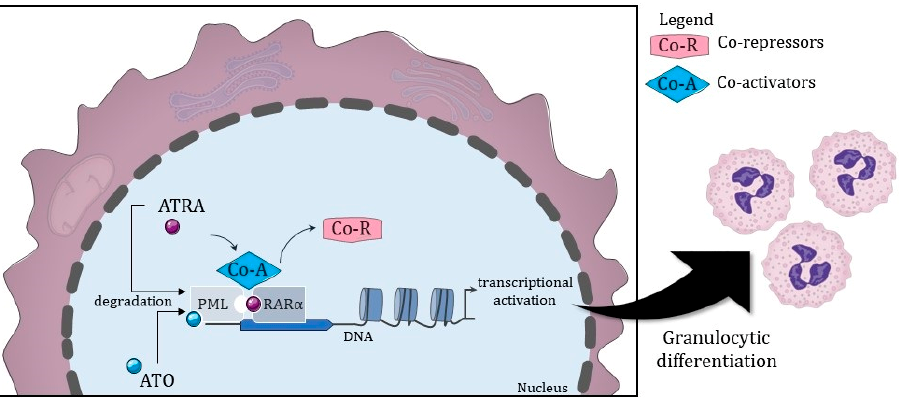
Figure 4. ATRA and ATO binding and dissociating corepressors leading to cell differentiation. APL target therapy deactivated the repression complex caused by the PML-RAR α protein and returned genetic transcription to cell differentiation, which leads cells back to responsiveness to the cell death mechanisms of chemotherapy .